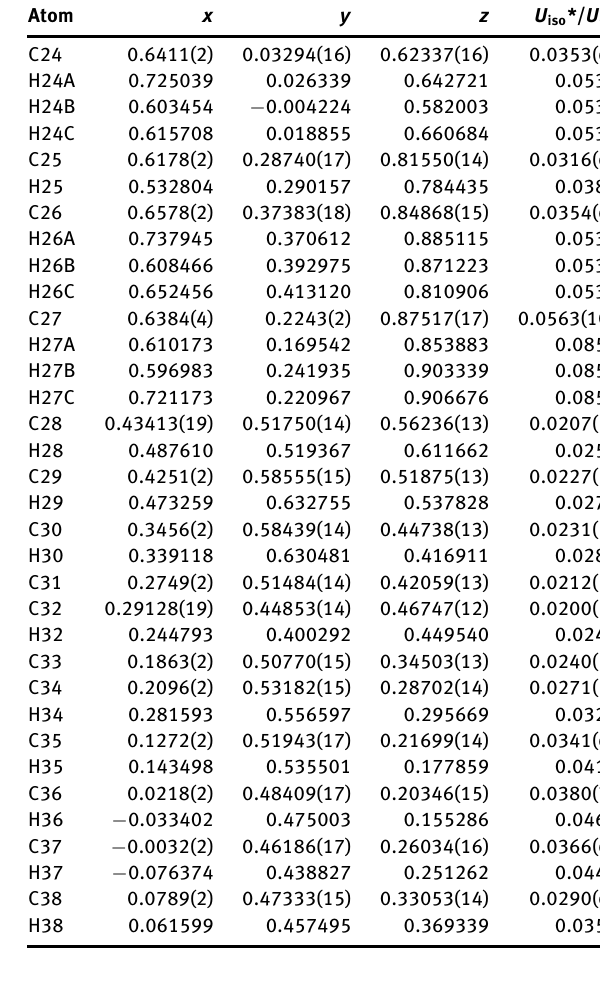
Table 2: Fractional atomic coordinates and isotropic or equivalent isotropic displacement parameters (Å 2